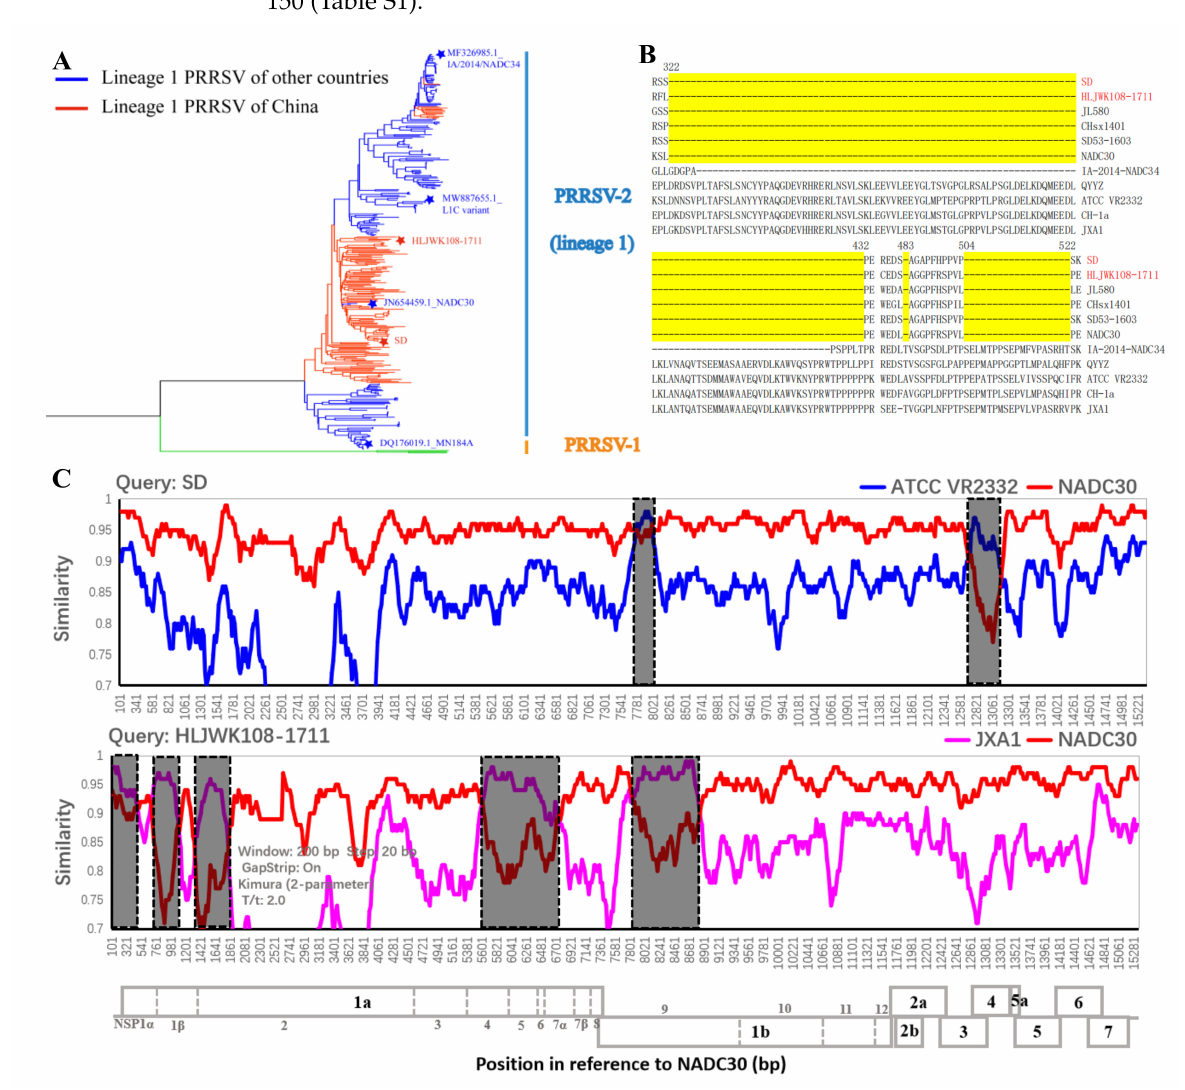
Figure 1. Phylogenetic analyses, NSP2-deduced amino acid alignment and recombination analyses of NADC30-like PRRSV SD and HLJWK108-1711. ( A ) Phylogenetic tree of strains SD and HLJWK108- 1711 based on 341 whole genomes of lineage 1. Blue lines represent lineage 1 strains in other countries. Red lines represent lineage 1 strains in China. Both MN184A, NADC30, the L1C variant and IA/2014/NADC34 are labelled with (cid:70) . Both SD and HLJWK108-1711 are labelled with (cid:70) . ( B ) The deletion characteristics of the NSP2 protein, and 131-aa discontinuous deletions are labelled with a yellow background. ( C ) Recombination analysis of SD and HLJWK108-1711. Recombination breakpoints are shown as black dotted lines. The background color of the major parental region (NADC30) is white, whereas that of the minor parental regions (ATCC VR2332 and JXA1) is gray. NADC30, ATCC VR2332, and JXA1 are shown in red, blue, and pink, respectively. 3.3. Both High-Dose and Repeated-Dose Tests of SD-R Are Safe for